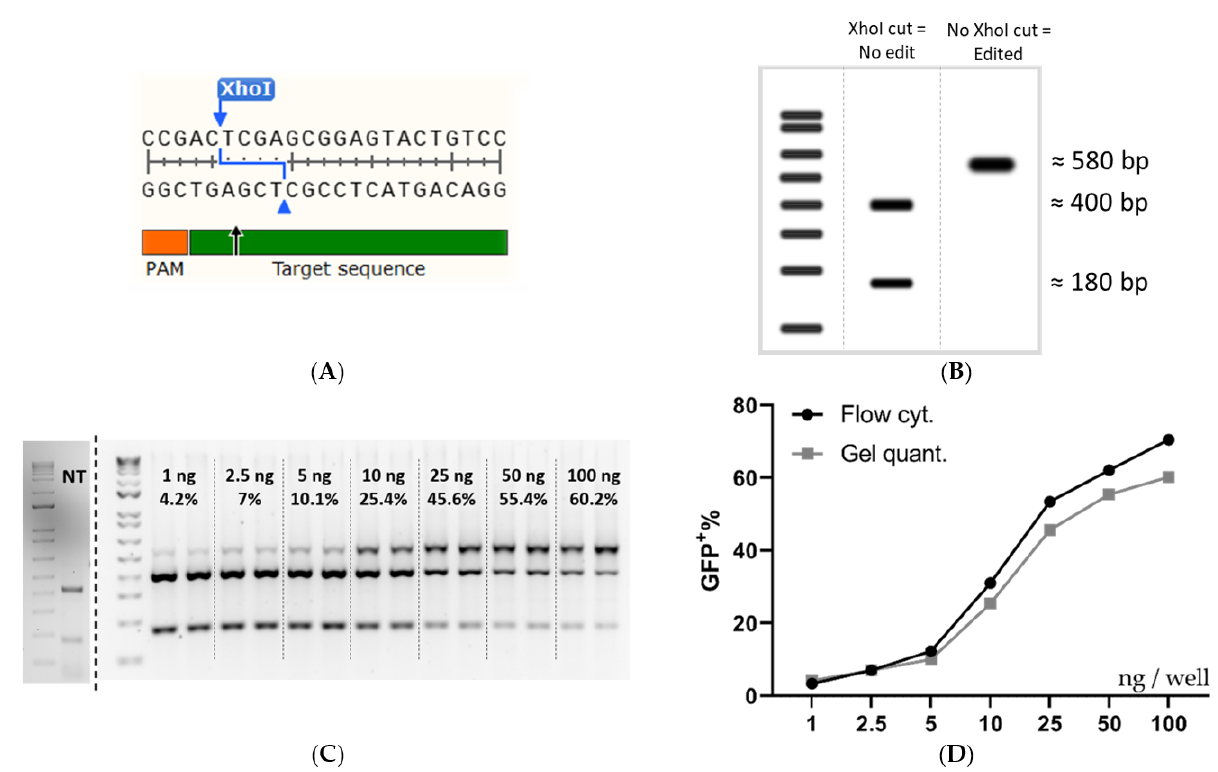
Figure 4. Validation of the flow cytometry data by RFLP analysis. ( A ) The DNA sequence at the Cas9 cleavage site in SL cells. ( B ) Expected RFLP outcome at 0 and 100% XhoI disruption. ( C ) An agarose gel was used for intensity quantification for RFLP analysis of HEK293T SL cells treated with increasing amounts of RNP: PF14 (MR 1:100). The dose of Cas9 per well (ng) and the mean quantified editing is superimposed on the gel image. ( D ) Comparison of a dose titration between flow cytometry quantification and RFLP quantification. Linear y -axis against log 10 x -axis. Flow cytometry quantification was done in triplicate, n = 1. Gel quantification was done in duplicate, n = 1. The cells in ( C , D ) were HEK293T SL cells treated with an increasing dose of Cas9/well (MR 1:100 RNP: PF14, formulated in DMEM/PVA-PEG (5 w/v